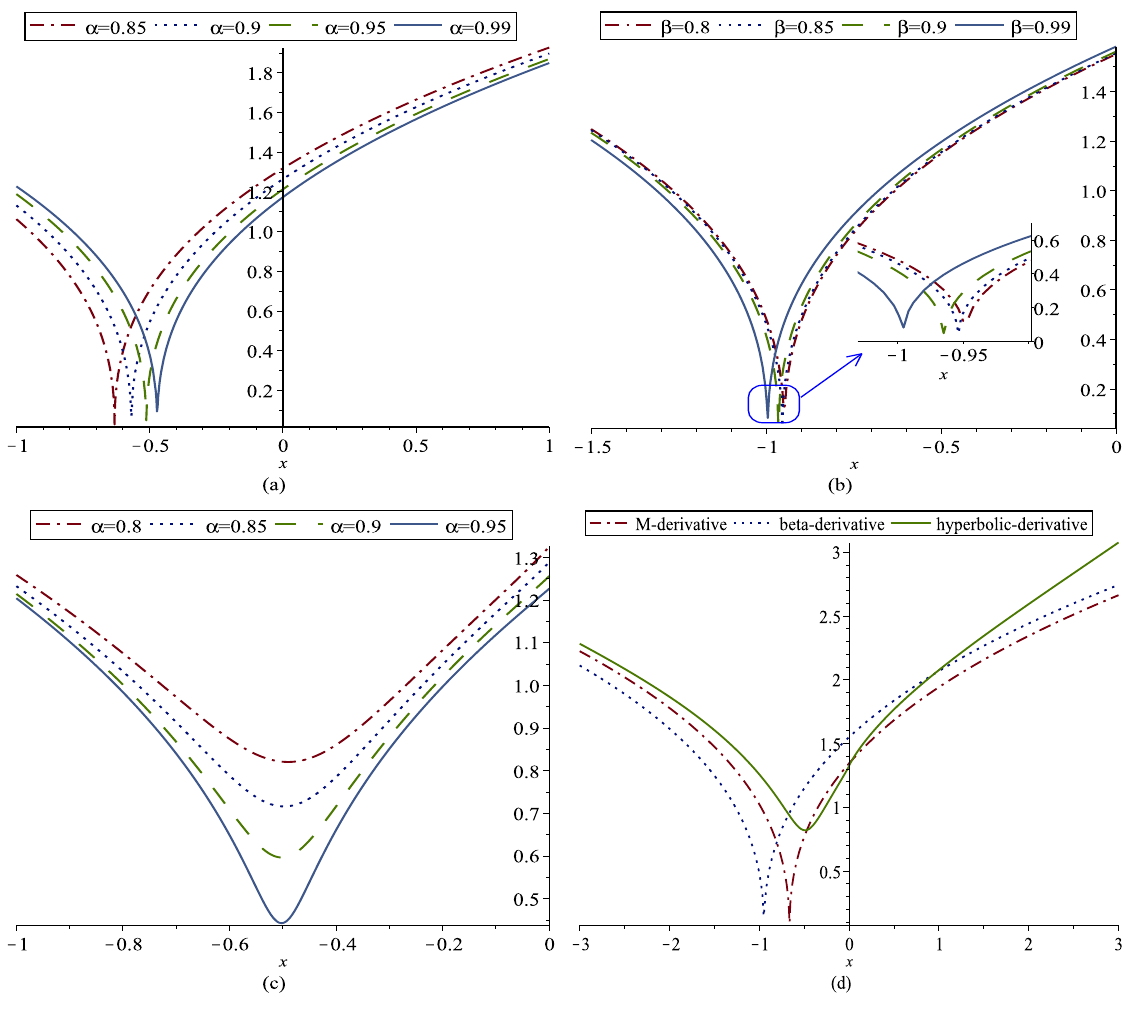
Figure 2. Exact solutions with α 1 = a = c = 2, λ 2 = λ 3 = t = 1, m = 3, n = 5, and ( a ) β = 0.9, and various α w.r.t. M-derivative (15), ( b ) various β w.r.t. beta-derivative (16) ( c ) various α w.r.t. hyperbolic-derivative (17) ( d ) α = β = 0.8, and various